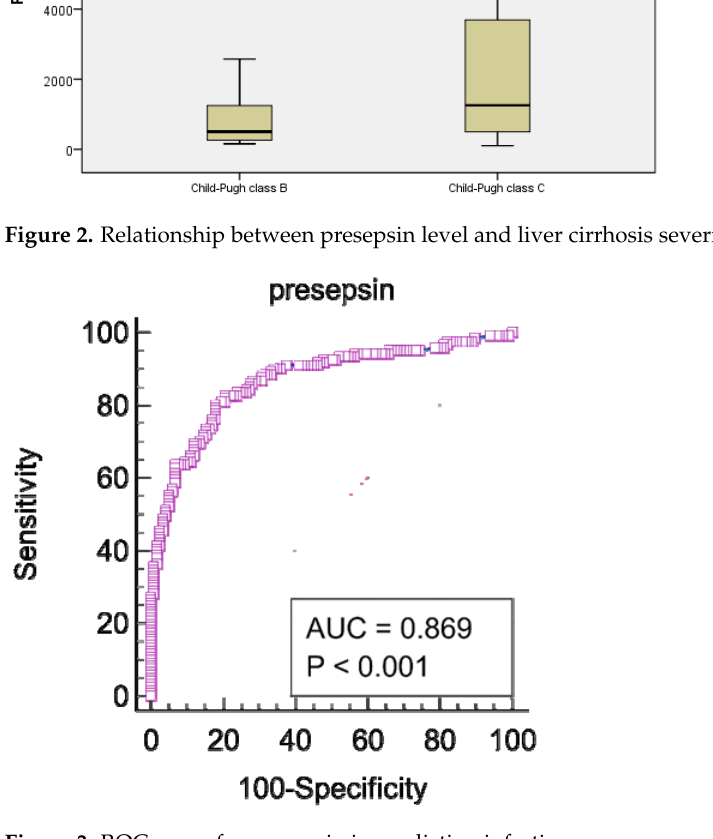
Figure 3. ROC curve for presepsin in predicting infections. Table 3. Comparisons of discriminating abilities of tested biomarkers presented as areas under the curve (95% CI).